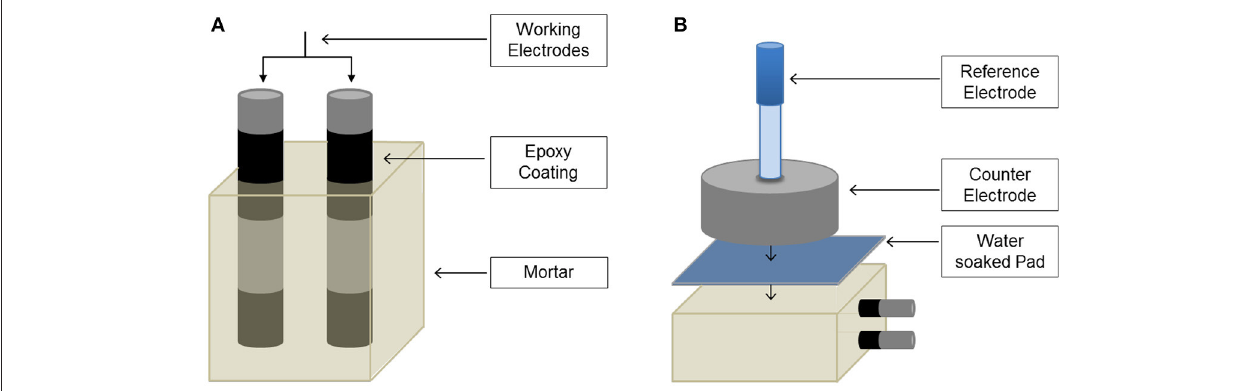
FIGURE 1 | (A) Reinforced prismatic sample geometry, and (B) electrochemical testing setup (Criado et al., 2018).